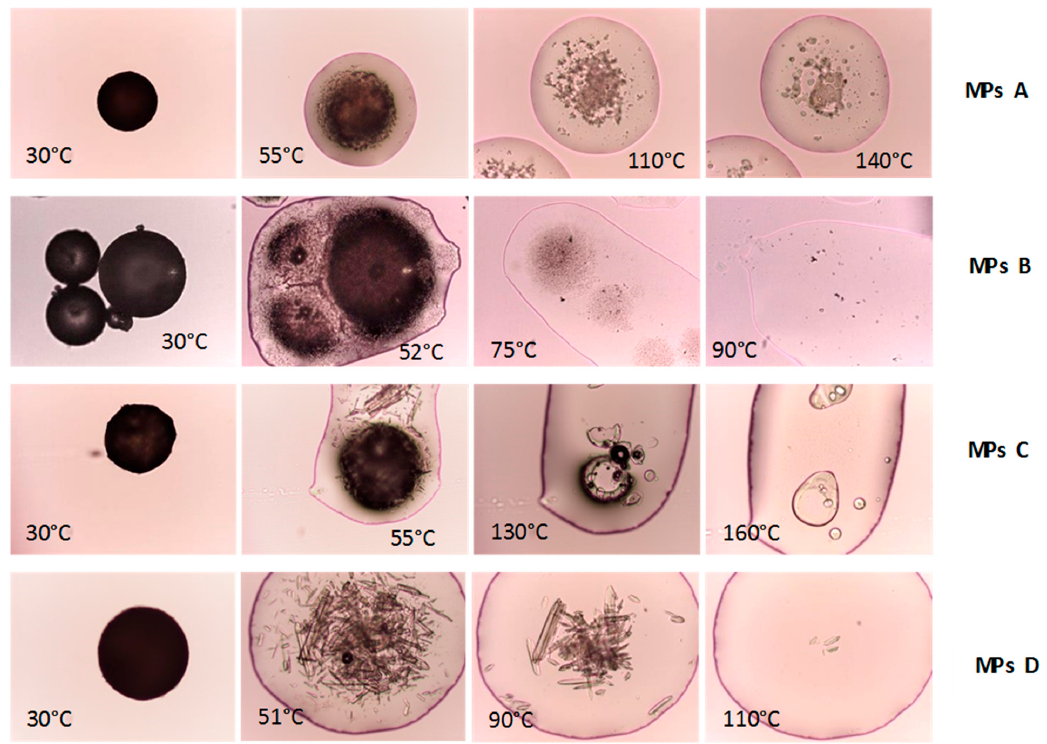
Figure 9. HSM images of microparticle formulations.